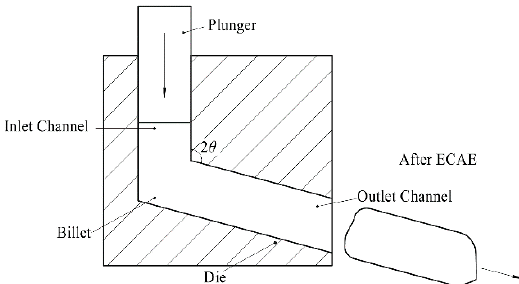
Figure 1. The principal scheme of ECAE billet processing through the 2θ -die.